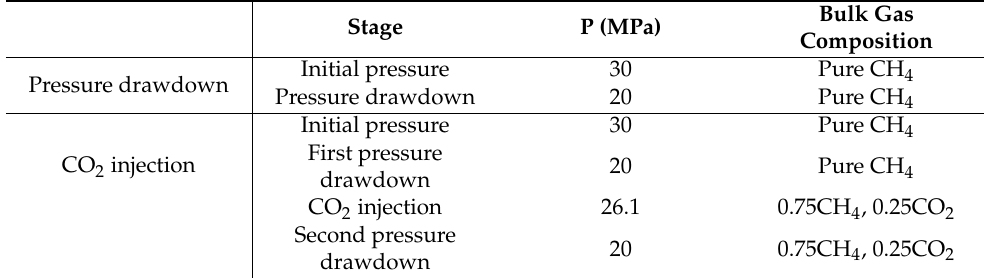
Table 2. Parameters for the setup of pressure and bulk gas composition during the pressure draw- down and CO 2 injection processes.